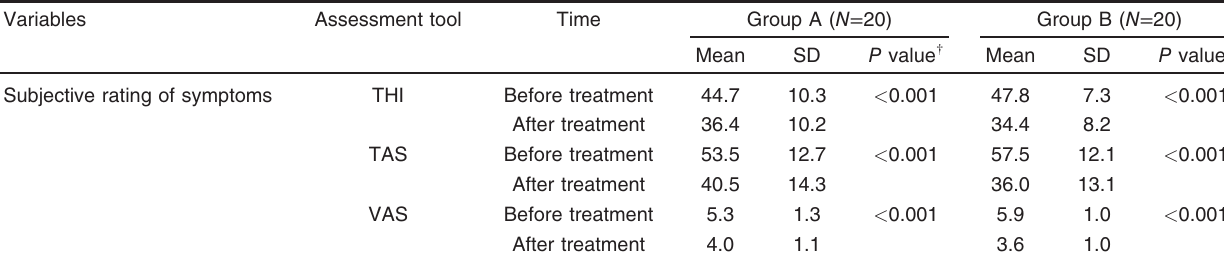
Table 3 Within-group comparison of subjective rating of symptoms before and after treatment